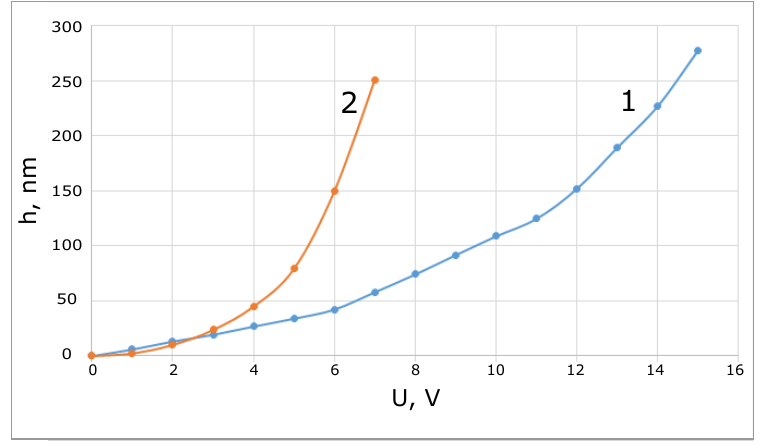
Figure 7. Membrane bias when voltage is applied for two different thicknesses: 1 µ m (labeled by 1), 0.4 µ m (labeled by 2).